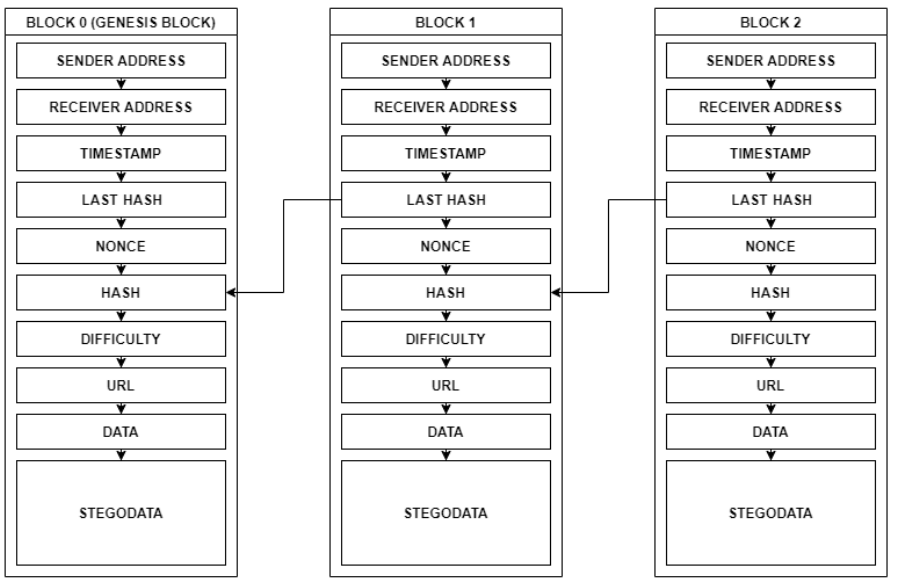
Figure 3. OTA-chain block structure.